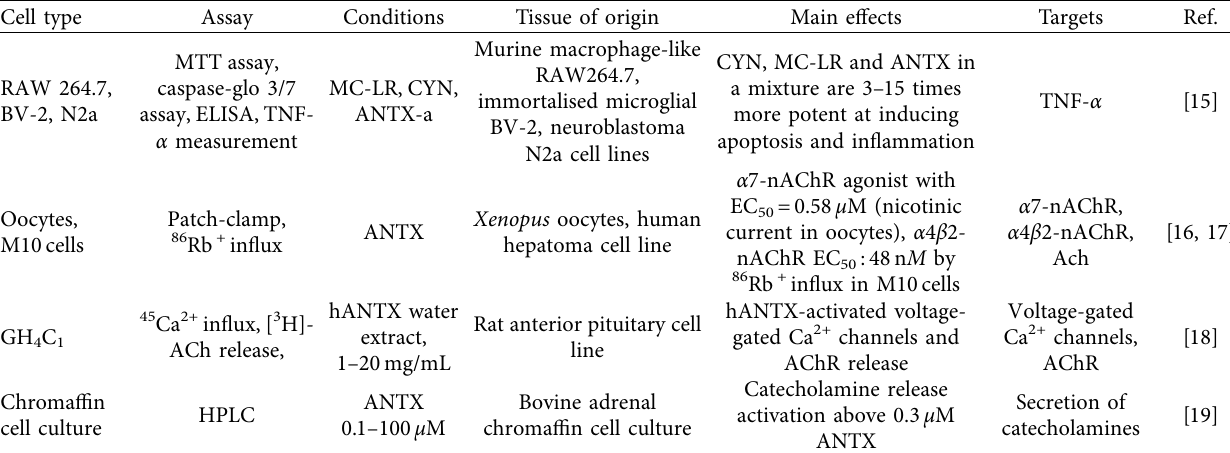
Table 2: Cytotoxicity of ANTX, hANTX and